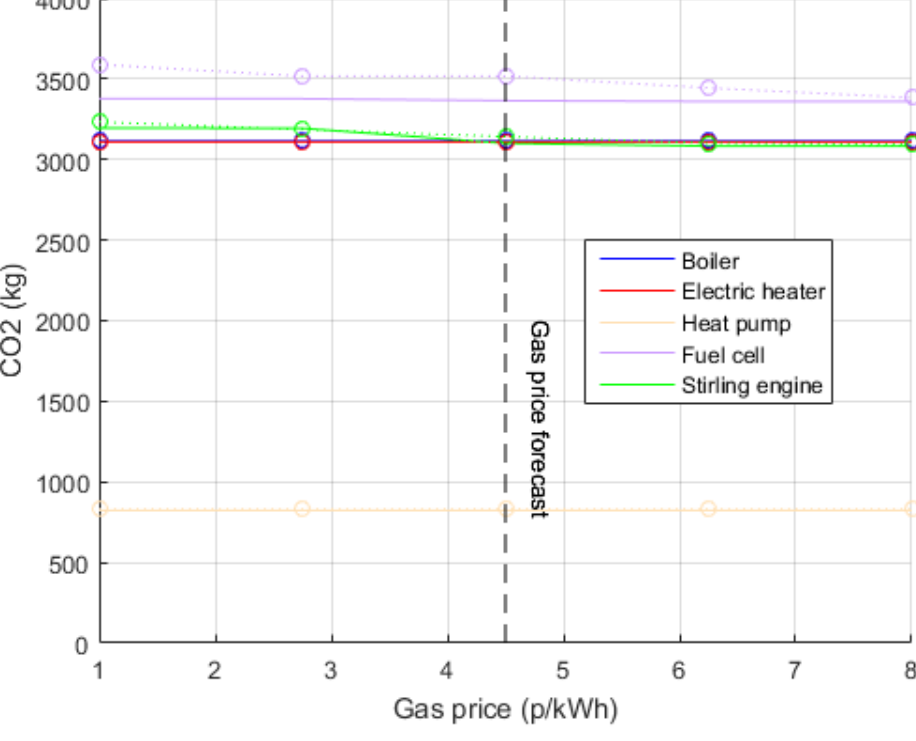
Figure 9. Emission sensitivity to natural gas price in the short run (solid lines) and long run (dotted lines with circle markers) regimes.